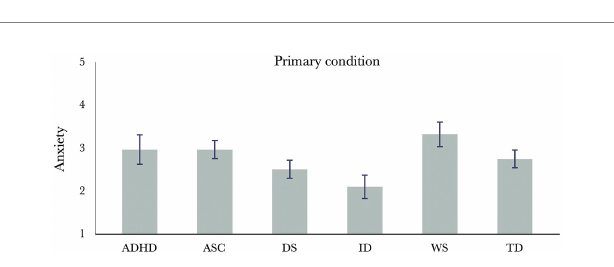
FIGURE 3 Anxiety levels in individuals with different primary conditions and TD siblings. Anxiety is measured with a 5-point Likert scale from 1 (not anxious) to 5 (very anxious). The anxiety level of individuals with NDCs and TD siblings was reported by their parents or caregivers. NDCs = neurodevelopmental conditions, ADHD = attention deficit disorder (with or without hyperactivity), ASC = autism spectrum condition, DS = Down syndrome, ID = intellectual disability, WS = Williams syndrome, TD = typically